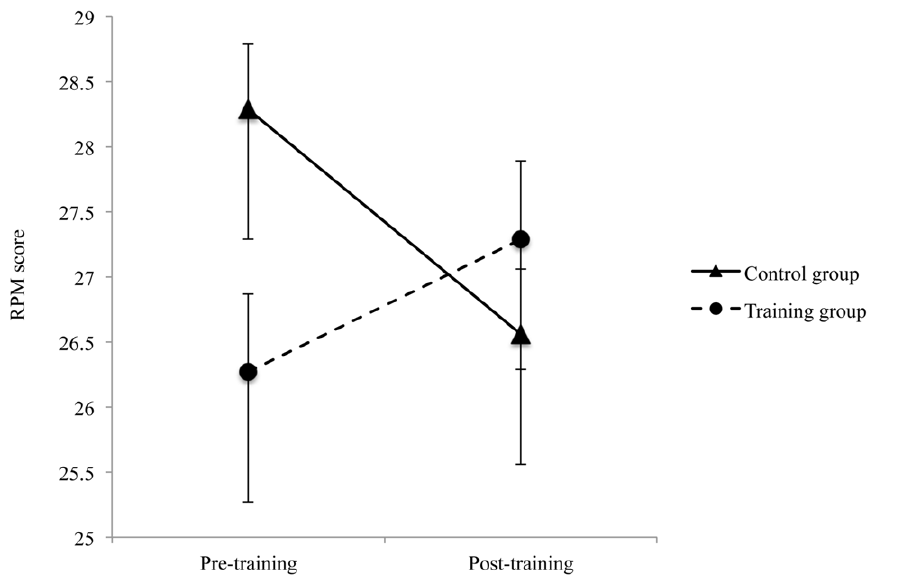
Figure 3. Transfer benefits of training to fluid intelligence. Figure 3 reports mean group scores achieved on the Raven’s Progressive Matrices (RPM; measure of fluid intelligence). Means (standard deviation) for the control and n -back trained groups are 28.29 (0.64), 26.56 (0.46) at pre-training and 26.27 (0.73), 27.29 (0.53) at post-training, respectively.